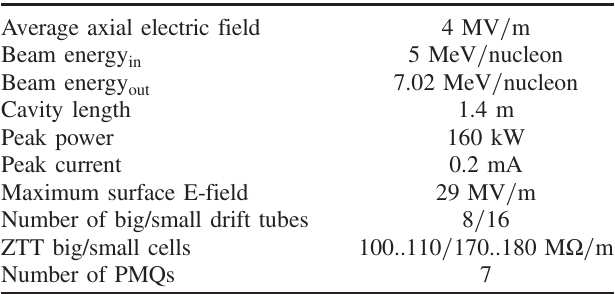
TABLE II. Parameters of NIMMS QA-DTL cavity.